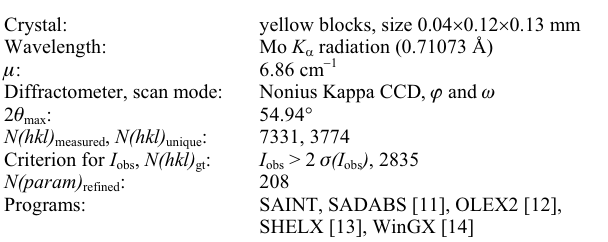
Table 1. Data collection and handling.